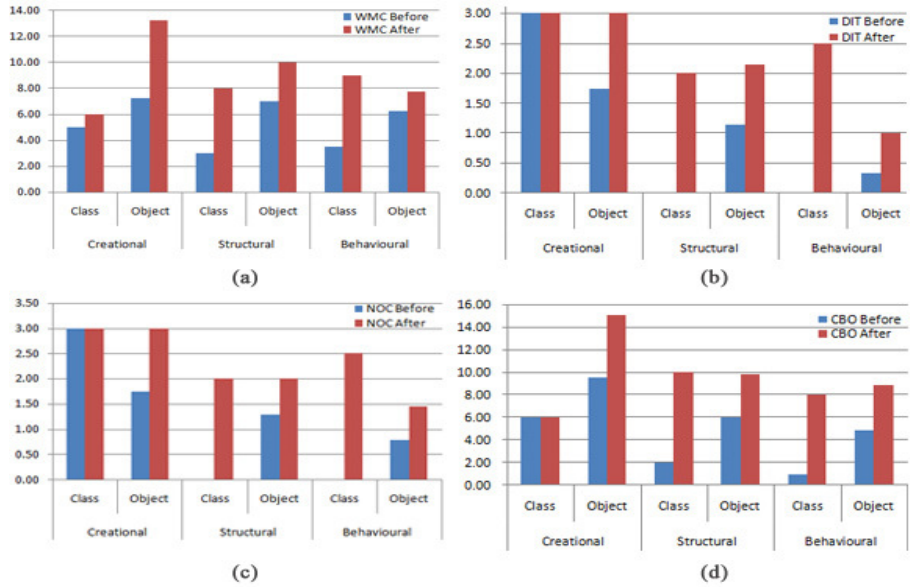
FIG.8. IMPACT ON VALUES OF CK METRICS FOR DIFFERENT CATEGORIES OF DESIGN PATTERNS (A) IMPACT ON WMC (B) IMPACT ON DIT (C) IMPACT ON NOC (D) IMPACT ON